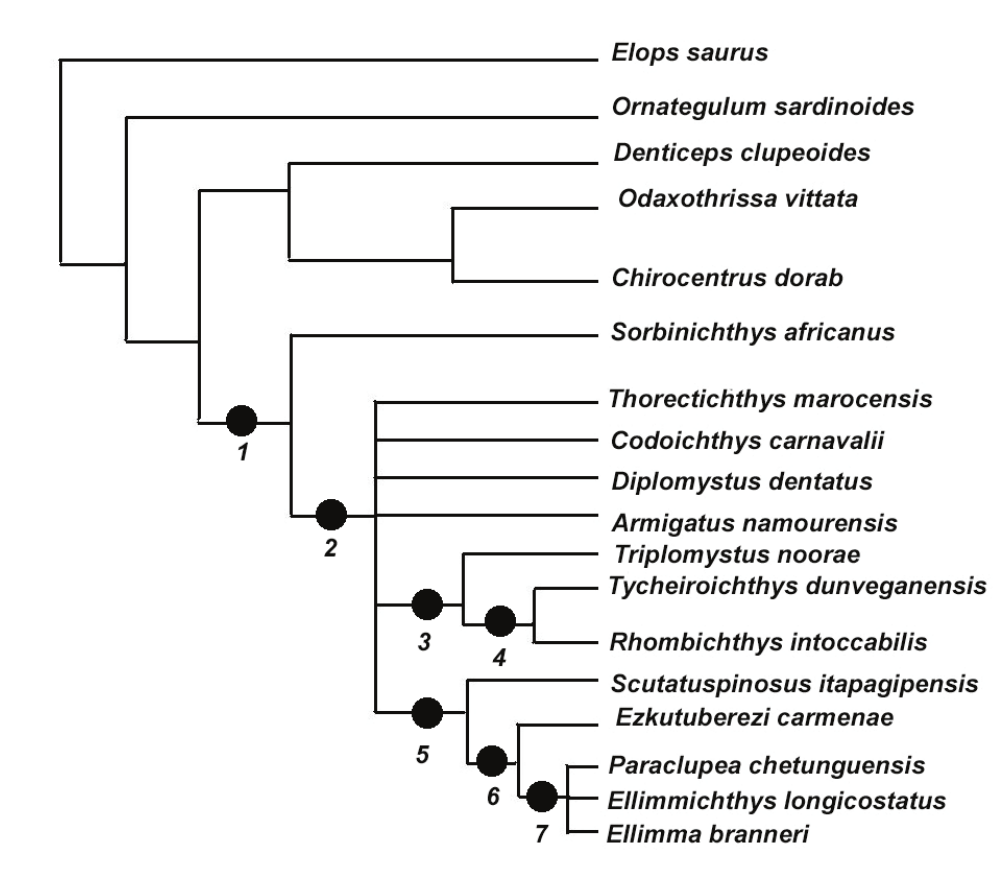
Figure 12. The majority rule consensus of 12 shortest trees obtained. Uniquely derived character is indicated with an asterisk symbol (*). The percentage of occurrence of arrangements are exposed together with change of character states. Synapomorphies supporting nodes are: Node 1 (†Ellimmichthyiformes, 75%): 10[0  1], 39 [0  1]; Node 2 (100%): 4*[0  1], 7[0  2], 12[0  1], 42[0  1]; Node 3 (66% ) : 29[0  1], 50[0  1], Node 4 (66%): 16[1  0], 36[1  0], 49[0  1]; Node 5 (66%): 12[1  0], 49[0  1], 53[0  1]; Node 6 (58%): 1 [0  1], 30[1  0]; Node 7 (75%): 5[0  1], 19[0  1], 60[0 